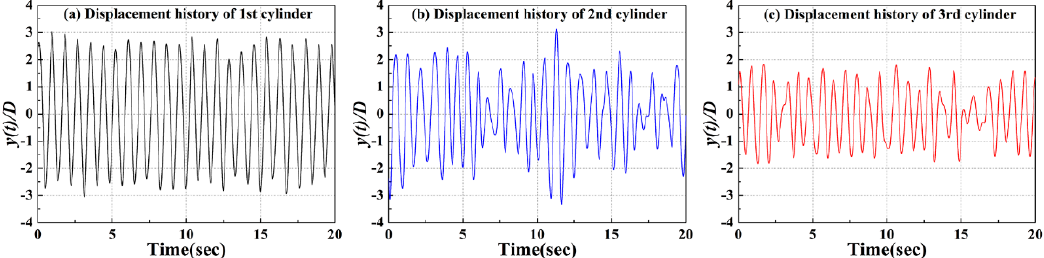
Figure 15. Time history curves of displacement for three cylinders when Re = 100,000.